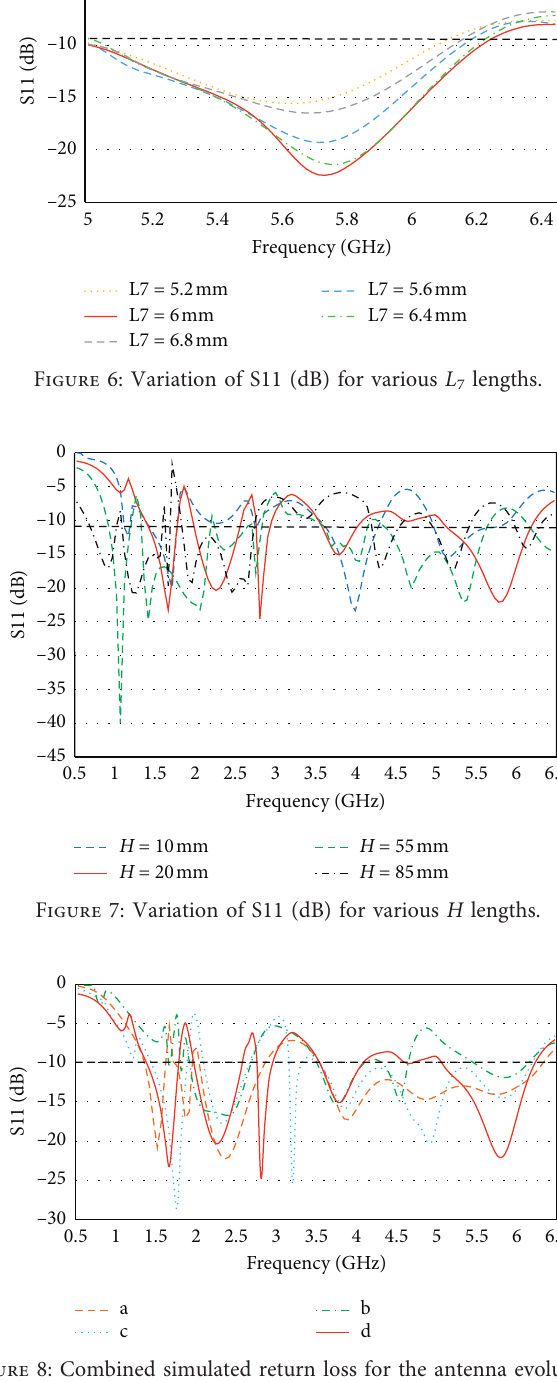
Figure 8: Combined simulated return loss for the antenna evolutions.